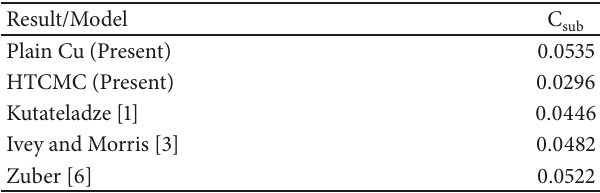
Figure 9: Normalized CHF comparison of HTCMC and plain surface with subcooling. Table 1: The coefficient “C sub ” of (5) for subcooled CHF.